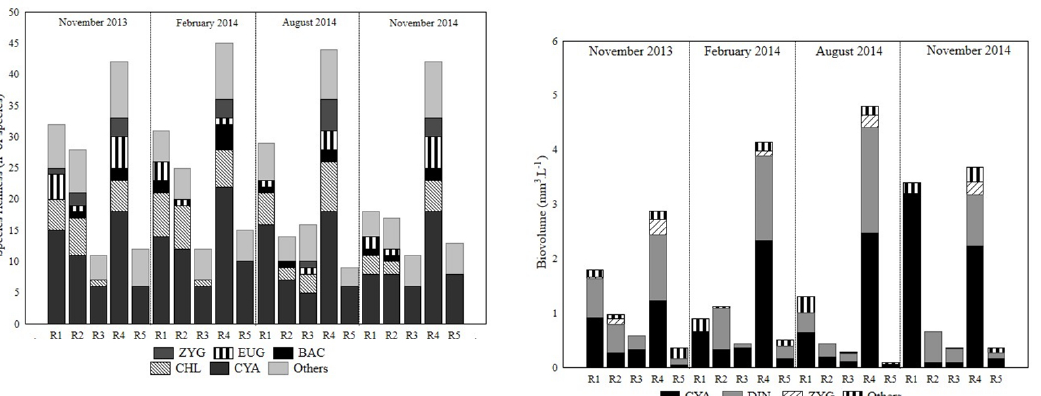
Figure 4. Temporal and spatial distribution of phytoplankton species richness in the reservoirs studied between November 2013 and November 2014 (ZYG- Zygnematophyceae; EUG- Euglenophyceae; BAC-Bacillariophyceae; CHL-Chlorophyceae; CYA-Cyanobacteria; Ilha Solteira Reservoir - R1; Jupiá Reservoir - R2; Porto Primavera Reservoir - R3; Três Irmãos Reservoir - R4; Rosana Reservoir - R5).